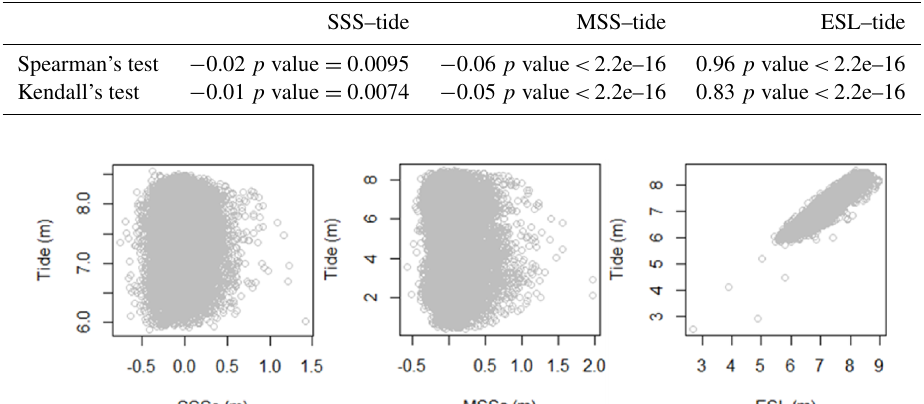
Table 4. Spearman’s ρ coefficients (and associated p values) as a measure of dependence between the tide and the other variables.